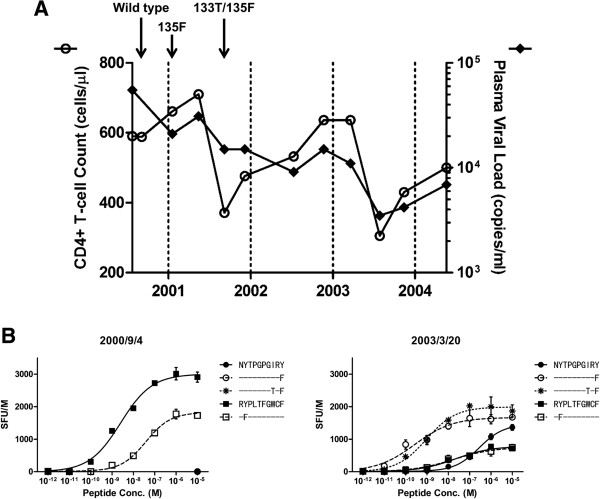
Longitudinal analysis in one individual. (A) Time courses of the surrogate markers are shown. CD4+ T cell count (left axis, white circle) and pVL (right axis, black circle) are plotted on the chart. Each arrow indicates the earliest time point when the sequence above the arrow was observed. (B) IFN-γ ELISpot assay was performed by using serially diluted peptide set and expanded PBMCs. Two time points were tested for the assay. At the earlier point, 2000/9/4, the patient harbored wild type sequence around the Nef126-10/Nef134-10 region, and at the latter point, 2003/3/20, the sequence displayed 133T/135F. Mutants as well as wild type peptides of Nef126-10 or Nef134-10 epitopes were used in the assay. Each point represents the average SFU of duplicate wells after subtraction of background, and each error bar shows standard deviation.